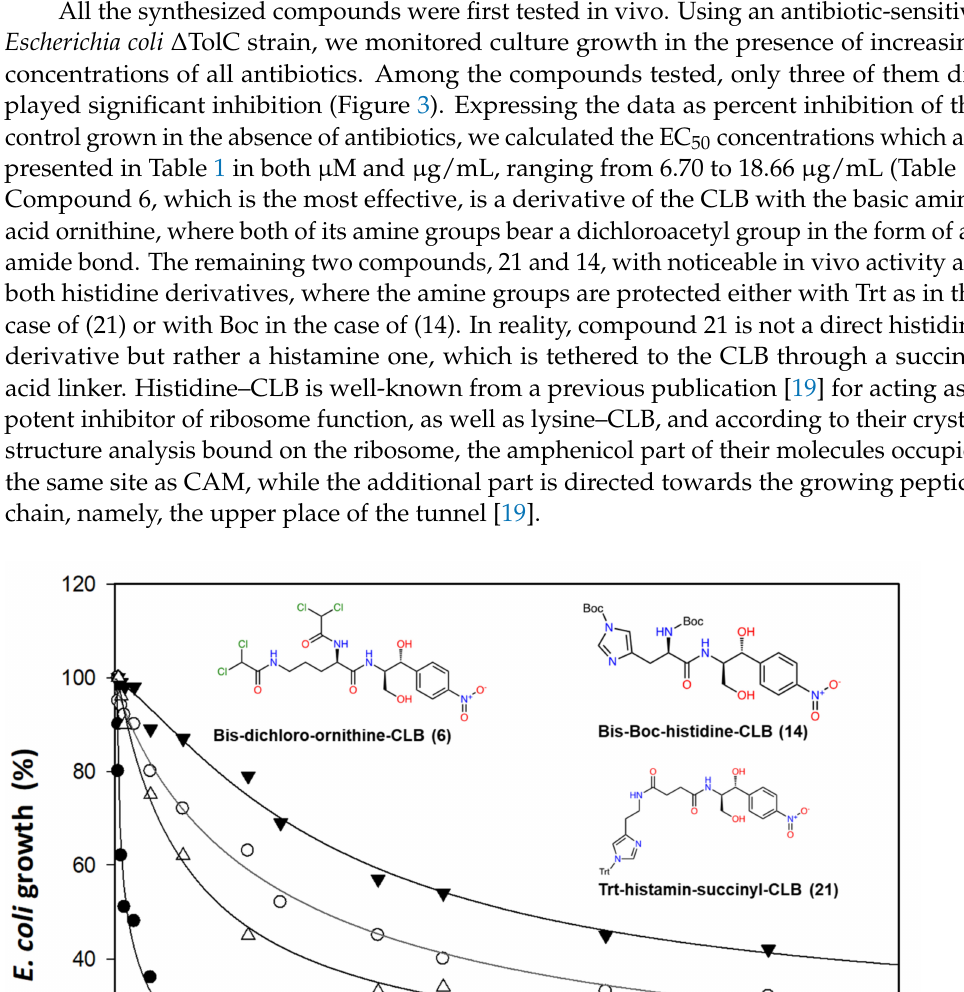
) Trt-histamine– (cid:35)